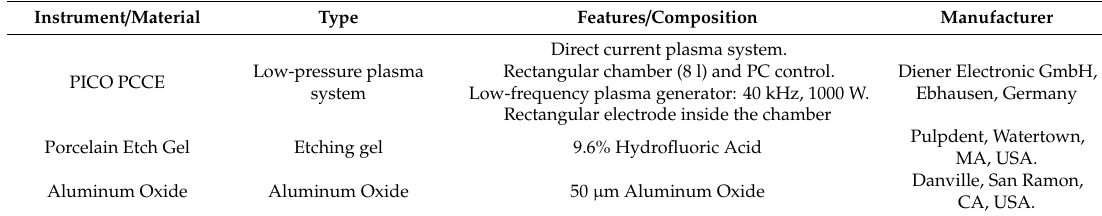
Table 3. Instrument and materials used for surface